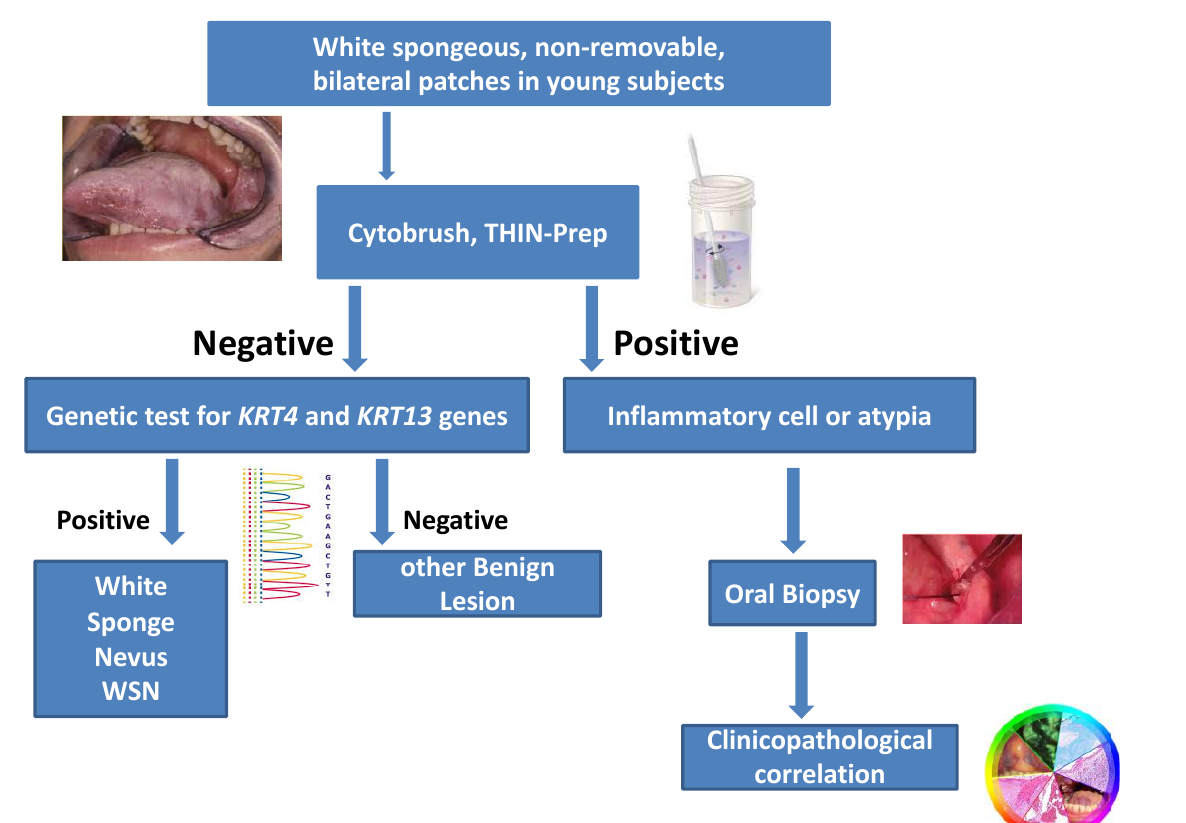
Figure 4. Proposed diagnostic workflow for White Spongeous lesions of the oral cavity.